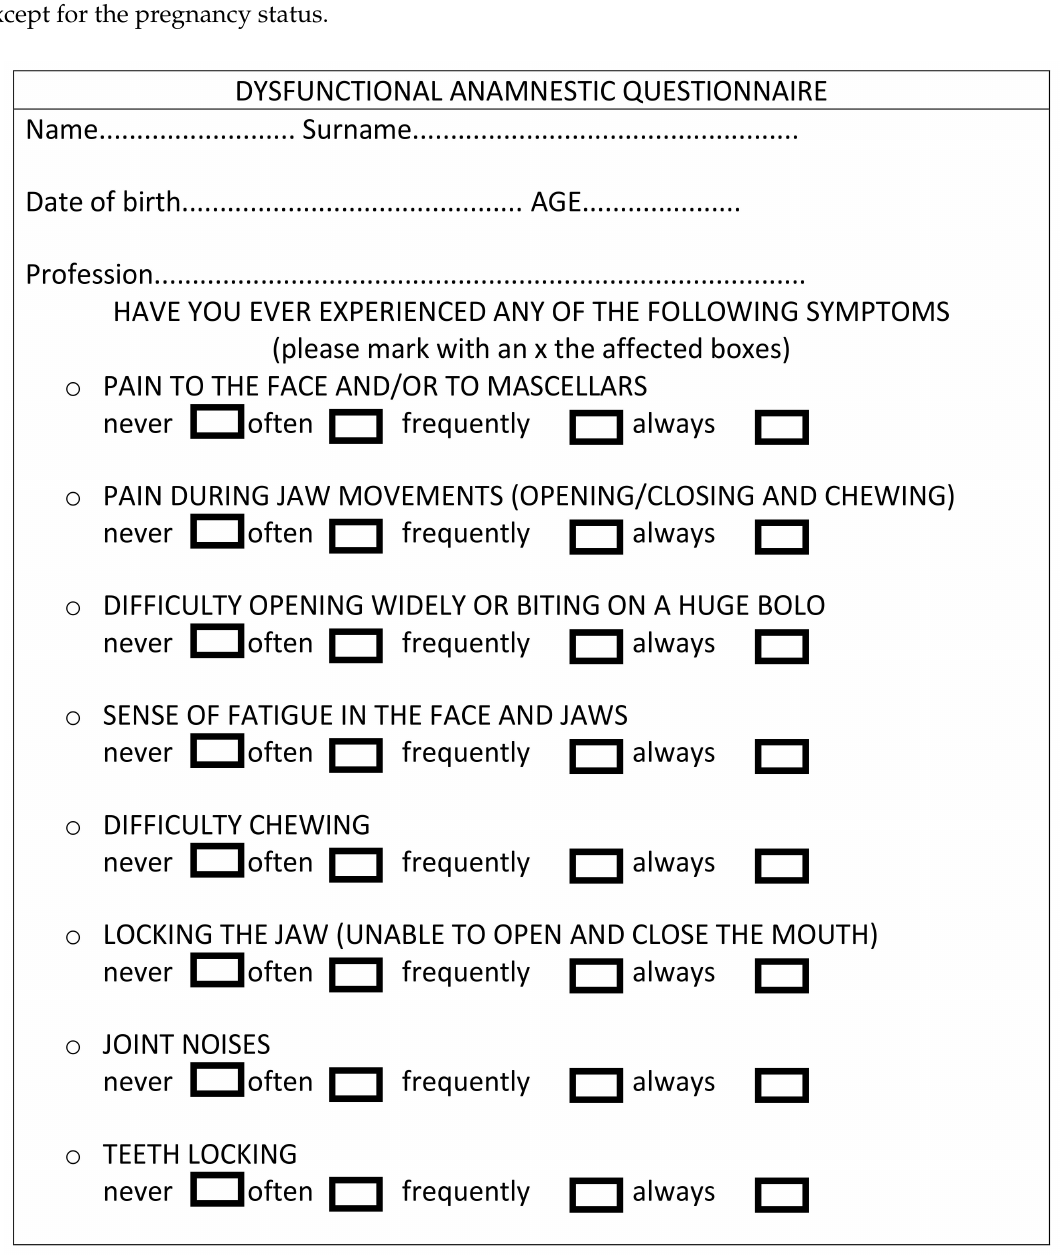
Figure 1. Example of the anamnestic Helkimo